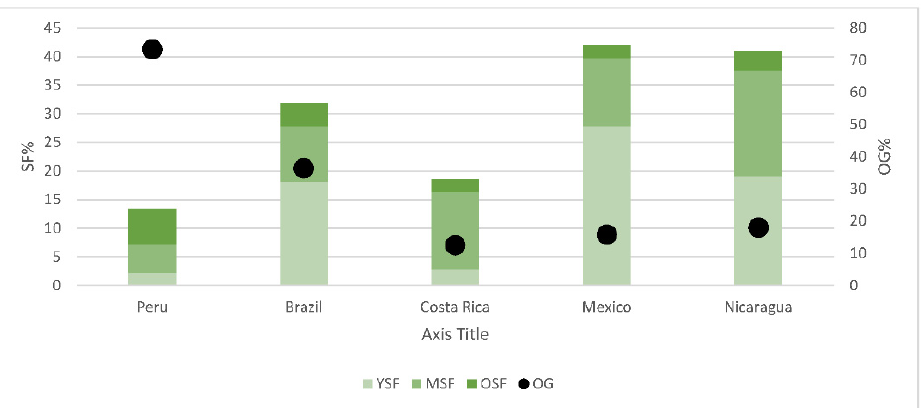
Figure 1. Secondary forest stages (stacked column) and old-growth forest (dot) as a percentage in Figure 1. Percentage of land cover types on farms (<115 ha) in the Amazon region (0–2500 m) 2008. YSF, young secondary forest ( ≤ 20 years); MSF, mid (20–60 years); OSF, old (60–100 years); OG, according to the 2012 agrarian census